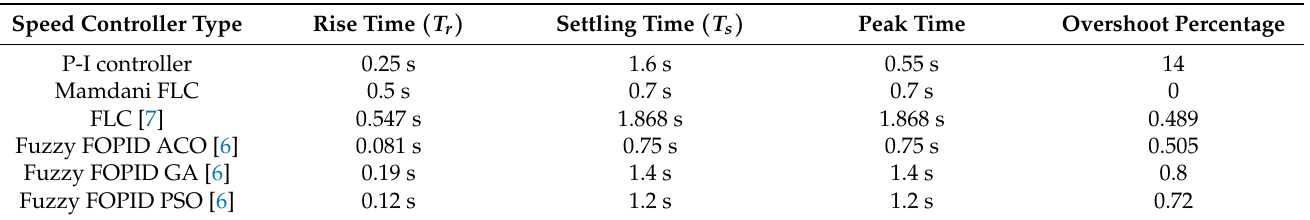
Table 5. Performance comparison between P-I controller and Mamdani fuzzy logic controller with fuzzy FOPID speed controllers